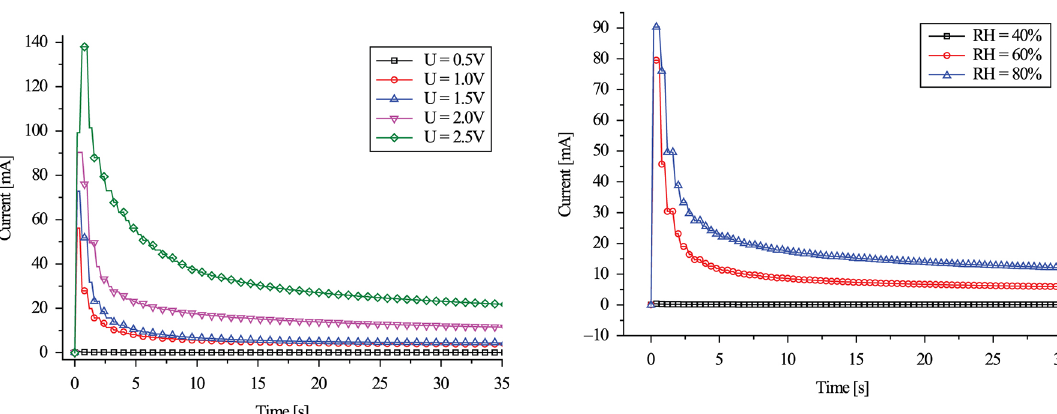
Figure 6. Electrical response of N117 based IPMC with Na + activated by U=2.0V conditioned in environments with different relative humidity.